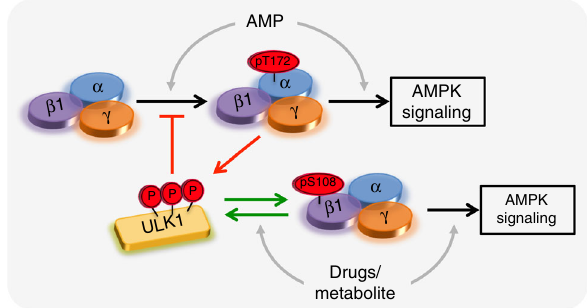
Fig. 9 An integrated model for ULK1 regulation of β 1-AMPK signaling. The initial ULK stimulus (e.g., Ser555 phosphorylation) is provided by AMPK, activated itself in response to energy stress and elevated AMP:ATP. Once activated, ULK1 suppresses Thr172 phosphorylation and AMPK sensitivity to AMP via negative feedback ( red arrows ) 20 . ULK1 simultaneously phosphorylates Ser108, sensitizing AMPK to drugs/metabolites acting at the ADaM site. This would promote AMP-independent AMPK signaling and maintain ULK1 activity via positive feedback ( green arrows ). In our cell model, activity of α 2(T172A) AMPK is not elevated in response to AMP and requires additional stimulation with A-769662 to achieve